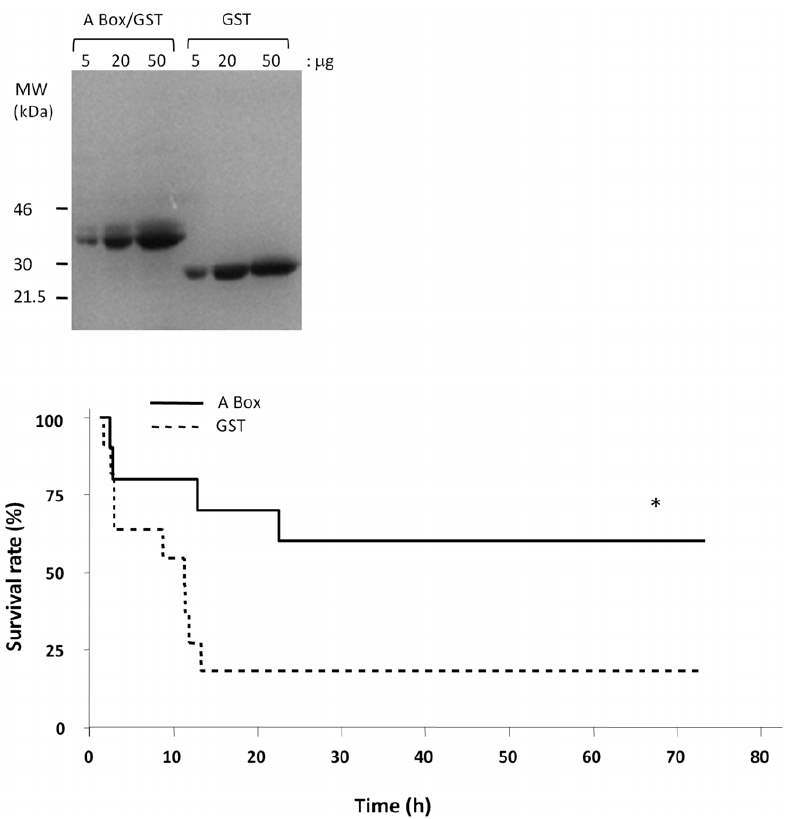
Figure 5. Inhibition of HMGB1 activity protects mutant mice against the lethal effects of heatstroke. ( A ) SDS-PAGE analysis of the recombinant A-Box and GST control proteins expressed and purified from E. coli is shown. Increasing amounts of purified proteins were resolved by SDS-PAGE and stained with Coomassie blue; ( B ) Mutant mice were pretreated (i.p. injection) with A Box 600 m g/mouse; or GST control and heatstroke was induced by passive exposure to environmental heat until the core temperature reached 42.7 u C. Pretreatment with A Box before heat stress protected the mutant mice against the lethal effects of heatstroke. *P=0.04 Kaplan-Meier log-rank testing between the two groups.